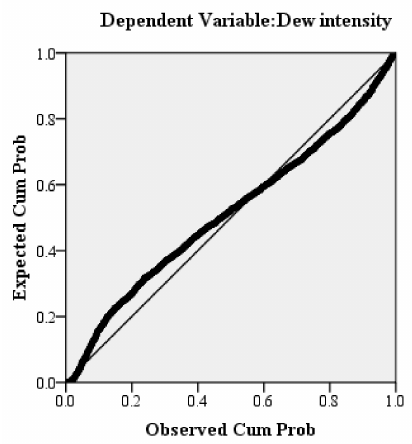
Figure A1. Normal P–P plots of the regression standardized residual.